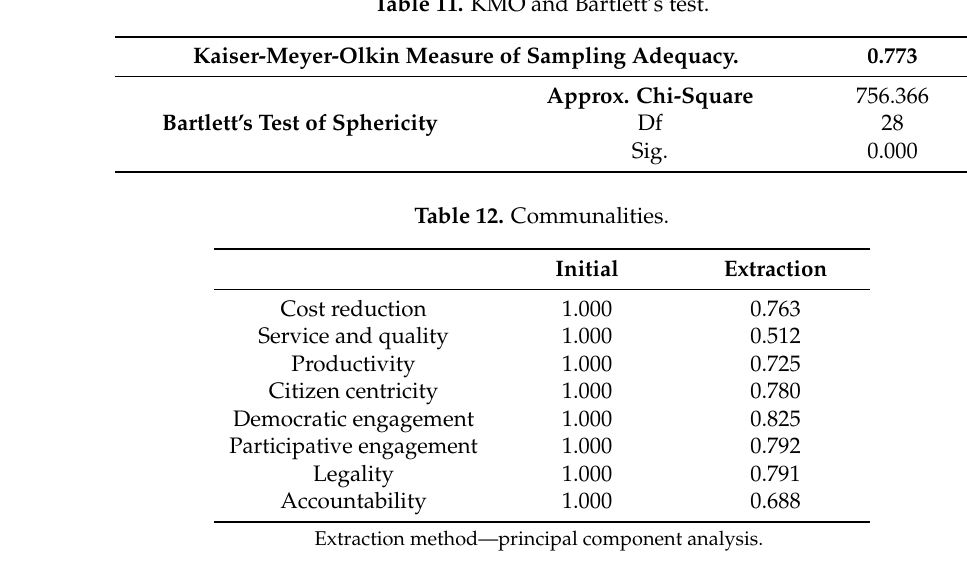
Table 11. KMO and Bartlett’s test.